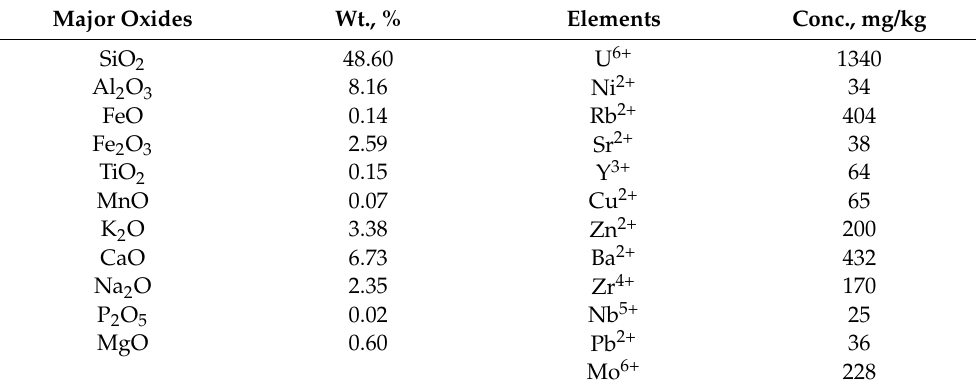
Table 6. Chemical composition of G. Gattar granite ore sample.